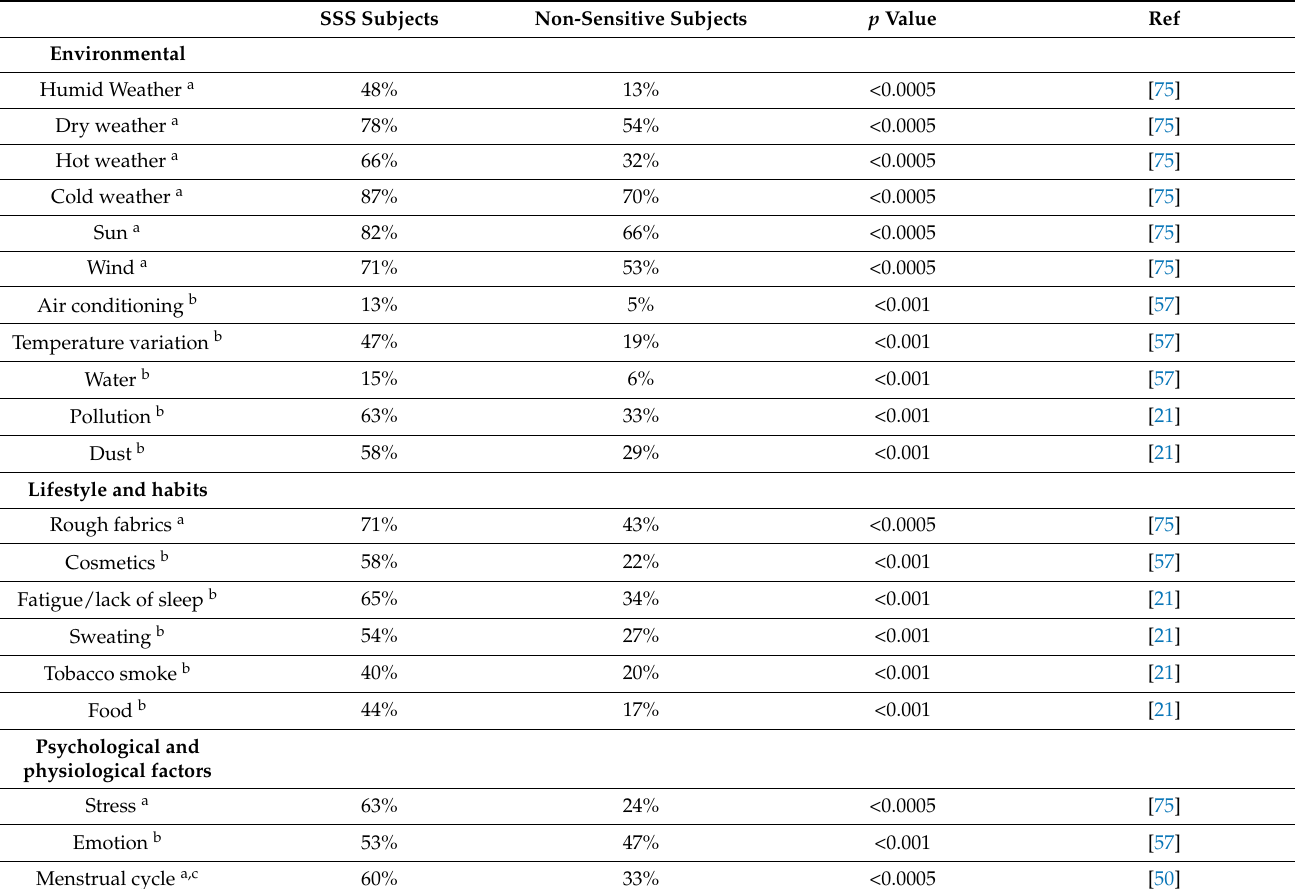
Table 6. Reported triggers of